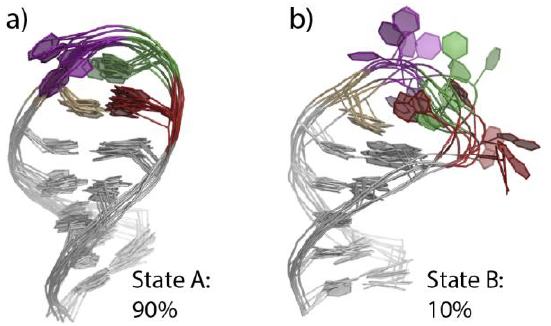
Figure 2. Two NMR ensembles of an r(UUCG) tetraloop derived from eNOE experiments. ( a ) Representative (random) conformations sampled from state A corresponding to a canonical fold. ( b ) Representative (random) conformations sampled from state B corresponding to less structured conformations. Note the fraying out of the guanine of the U•G pair. The PDBids of these NMR ensembles are 6BY4 and 6BY5. Figure adapted from [27].